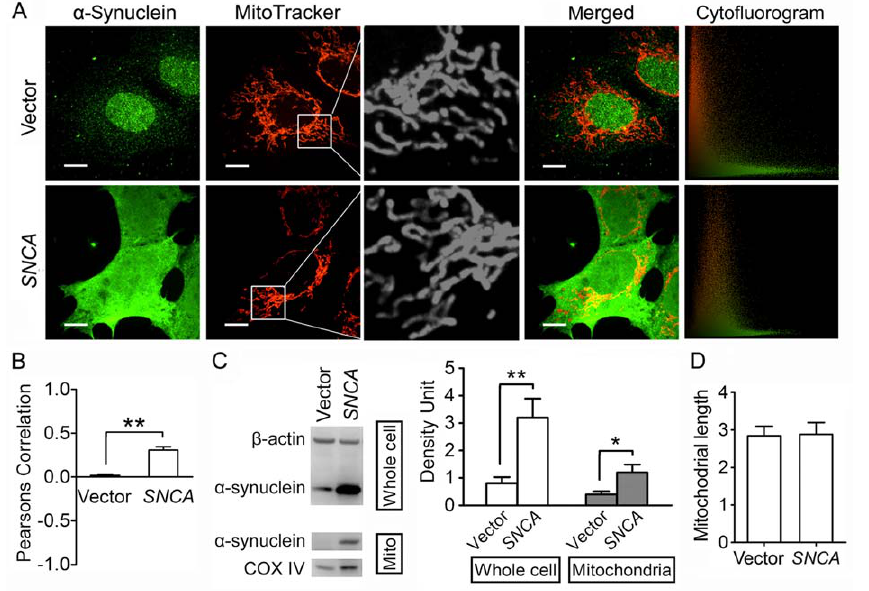
Figure 3. a -Synuclein overexpression promotes its mitochondrial localization without inducing mitochondrial fragmentation in SH- SY5Y cells. A. Representative double-staining images of a -synuclein (Green) and mitochondria (Red) in SH-SY5Y cells overexpressed with a - synuclein ( SNCA group) or transfected with an empty vector (Vector group) for 48 h. Amplified images further show that no obvious alteration in mitochondrial morphology between these two groups. Cytofluorogram analysis demonstrates that PC coefficient is remarkably elevated in a - synuclein overexpressed cells (PC=0.313104, CC Mx=0.840827, CC My=0.986122) compared with Vector group (PC=0.021315, CC Mx=0.964957, CC My=0.780582). Scale bars for 10 m m. B. Quantitative analysis demonstrates that PC coefficients are remarkably elevated in SNCA group compared with Vector group. C. Immunoblotting assay shows that a -synuclein expression levels are significantly elevated in SH-SY5Y cell lysates and mitochondrial lysates after transfected with SNCA for 48 h (n=4). D. Quantitative analysis of changes in mitochondrial length shows no significant statistic difference between SNCA group and Vector group. Images of 20 cells from each group were processed for cytofluorogram (B) and mitochondrial morphology analysis (D), and the experiment was repeated three times. *P , 0.05, **P ,